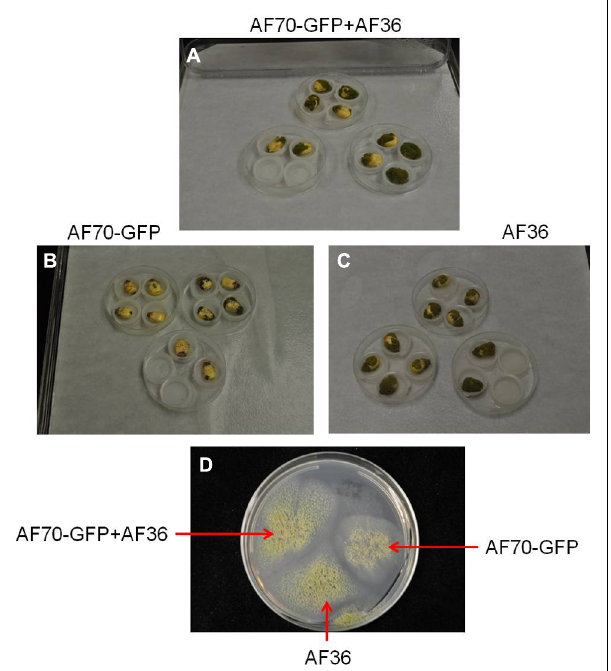
FIGURE 1 | Images of A. flavus fungal isolatesAF70-GFP andAF36 in a mixture (A) or grown separately (B,C) on inoculated corn kernels and in culture (D); compared on the seventh day of